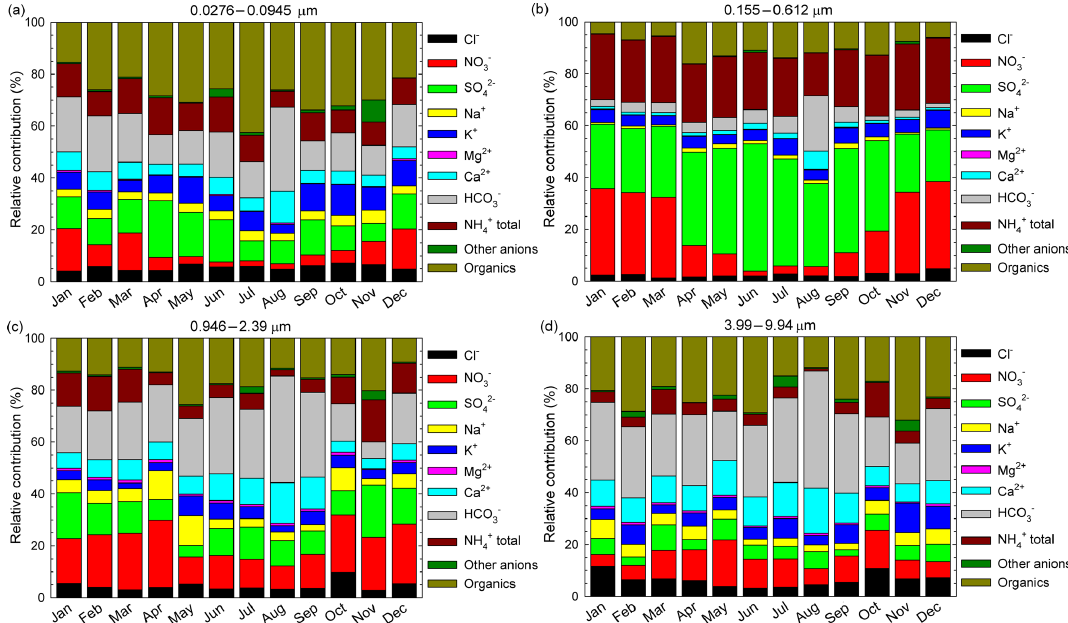
Figure 8. The relative contributions, as monthly averages, of identified and quantified water-soluble ions to total detected components in the 0.0276–0.0945µm (a) , 0.155–0.612µm (b) , 0.946–2.39µm (c) , and 3.99–9.94µm (d) size range grouped